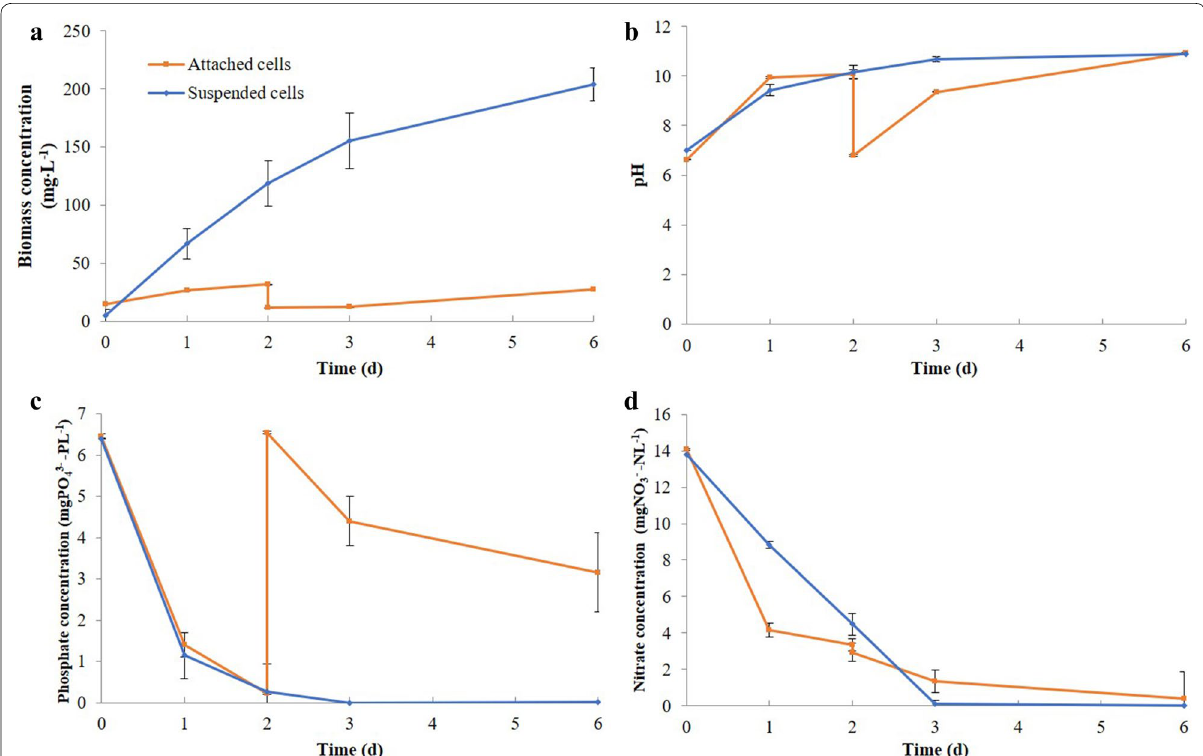
Fig. 5 a Biomass growth, b pH changes in liquid medium, c phosphorus and d nitrogen removal kinetics of C. vulgaris ACUF_809 cultivated in suspension and as attached biofilm in the PBR. The error bars correspond to the standard